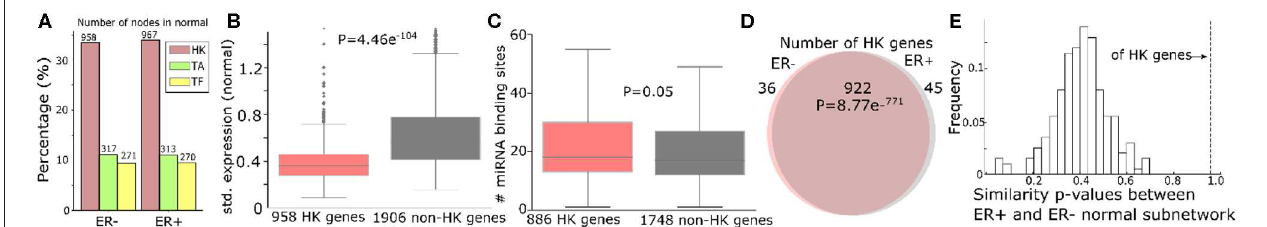
FIGURE 3 | Housekeeping genes make consistent ceRNA networks between ER- and ER normal samples. (A) Number (and the percentage to the total number of + nodes in the networks) of housekeeping (HK), tumor-associated (TA), or transcription factor (TF) genes in the ER- and ER normal ceRNA networks. (B) Standard + deviation of gene expressions of 958 HK genes and 1,906 non-HK genes in the ER- normal ceRNA network. (C) Number of miRNA binding sites on the 3 ′ UTR of 886 HK and 1,748 non-HK genes in the network. (D) Number of HK genes shared by ER- and ER normal ceRNA networks. (E) Distribution of the similarity of p -values + between the subnetworks of ER and ER- normal ceRNA networks with 922 HK genes or the same number of non-HK genes. The higher the p -value is, the more + similar the networks are Gera et al. (2018).